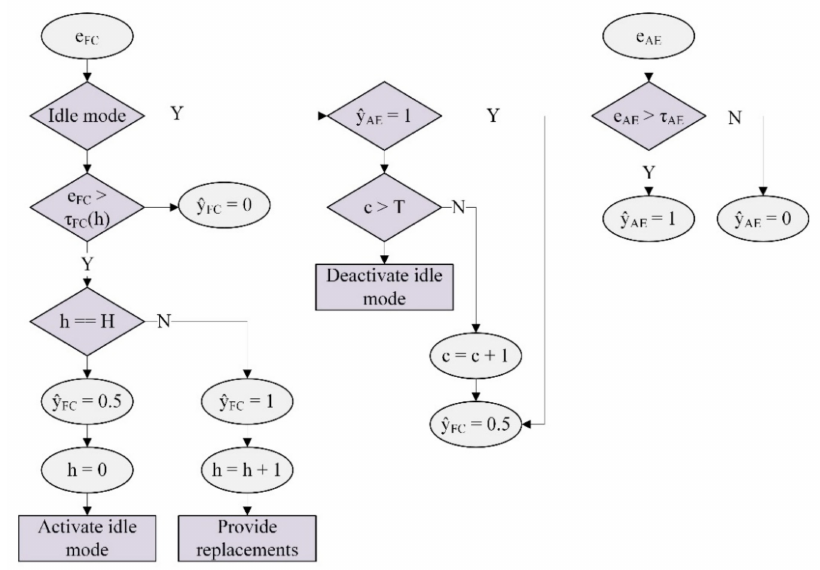
Figure 7. Principal workflow of the anomaly detection and correction (ADC) model.